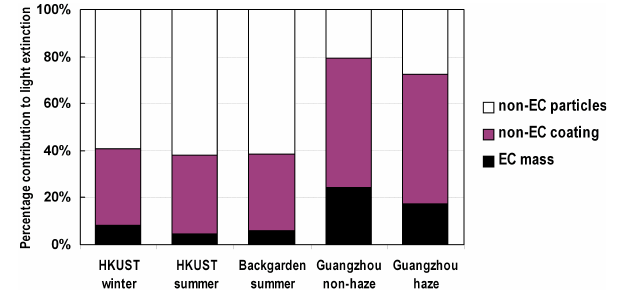
Fig. 6. Contributions of EC and non-EC coating in EC-containing particles to the observed light extinction coefficients in a few urban, suburban and rural locations in the Pearl River Delta region. The fraction of others was calculated to be the difference between the observed light extinction and the light extinction of EC-containing